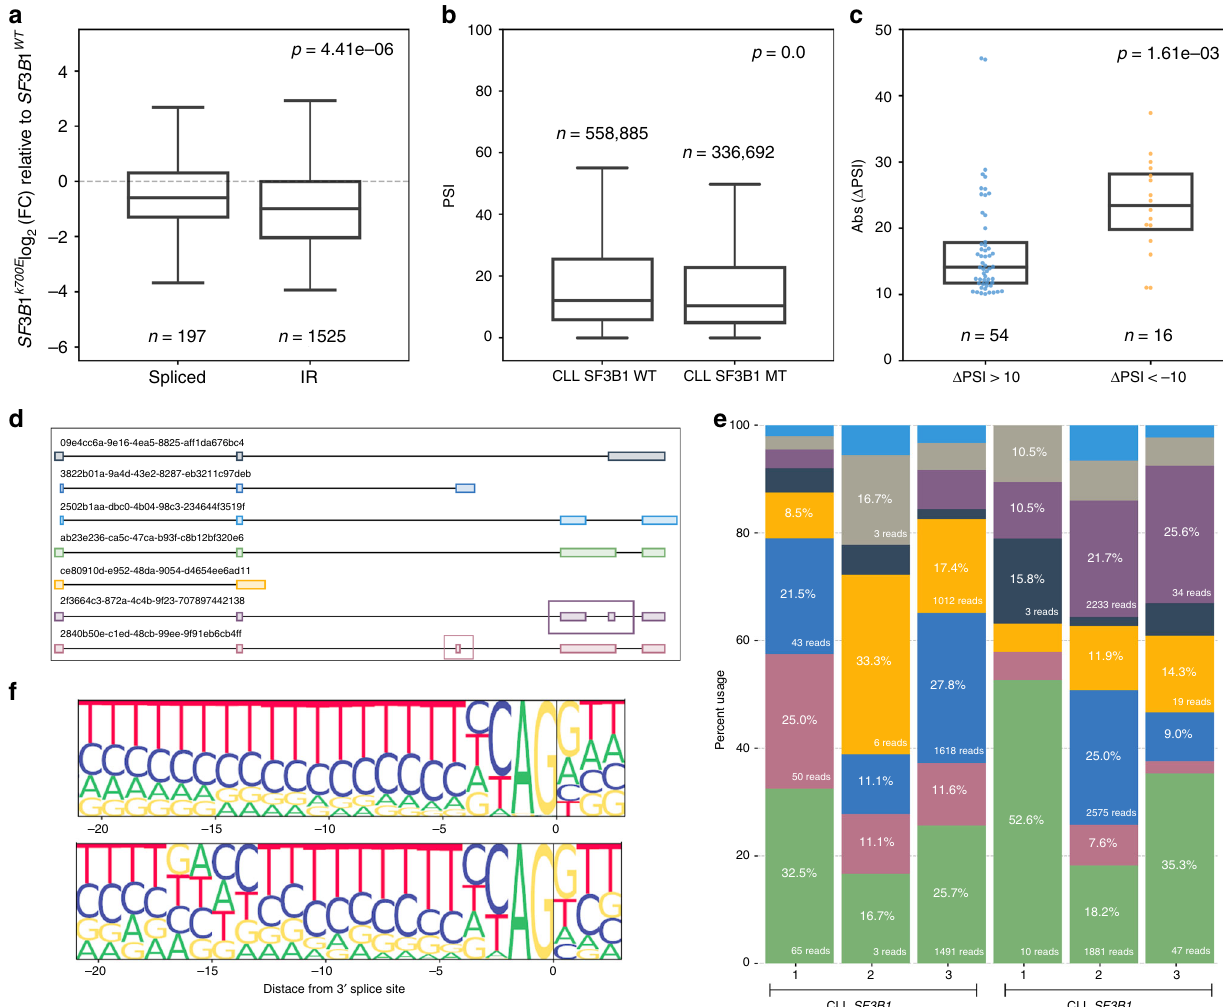
Fig. 4 Intron retention events are more strongly downregulated in CLL SF3B1 K700E . a Expression fold-change between SF3B1 K700E and SF3B1 WT of FLAIR isoforms with (IR) or without (spliced) retained introns. Boxplot median difference = 0.395. Source data are provided in a Source Data fi le. b PSI values of intron retention events identi fi ed in short read sequencing of CLL SF3B1 WT or CLL SF3B1 MT samples. Boxplot median difference = 1.69. Source data are provided in a Source Data fi le. c The change in PSI in signi fi cant intron retention events (corrected p < 0.1) identi fi ed in nanopore data that are more included in CLL SF3B1 K700E (blue) or more included in CLL SF3B1 WT (orange). Boxplot median difference = 9.32. P values for a – c are using two-sided Mann – Whitney U tests. Box-plots show median line, box limits are upper and lower quartile, and whiskers are 1.5× interquartile. d ADTRP gene isoforms, plotted 5 ′ to 3 ′ . The 632 bp intron that is differentially included is boxed in purple. A differentially skipped exon is boxed in pink. e Percent usage of each isoform in each CLL sample, with colors corresponding to isoforms in d . Gray bars represent all other isoforms not plotted in d . f Top: 3 ′ splice-site motif of constitutively spliced introns. Bottom: 3 ′ splice-site motif of signi fi cant intron retention events identi fi ed from short-read sequencing ( n =